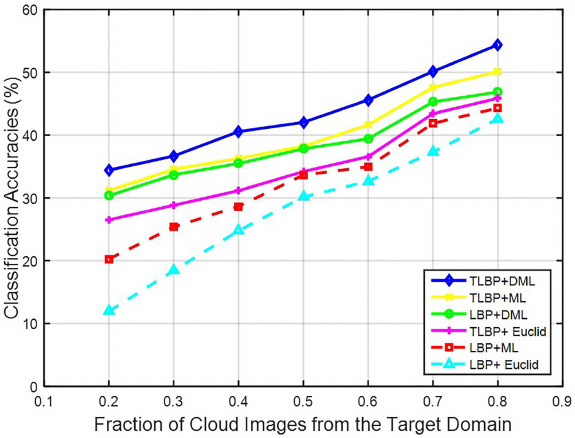
Figure 12. Cross-domain recognition accuracy in the case of MOC to CAMS domain shift when a varying fraction of cloud images are from the target